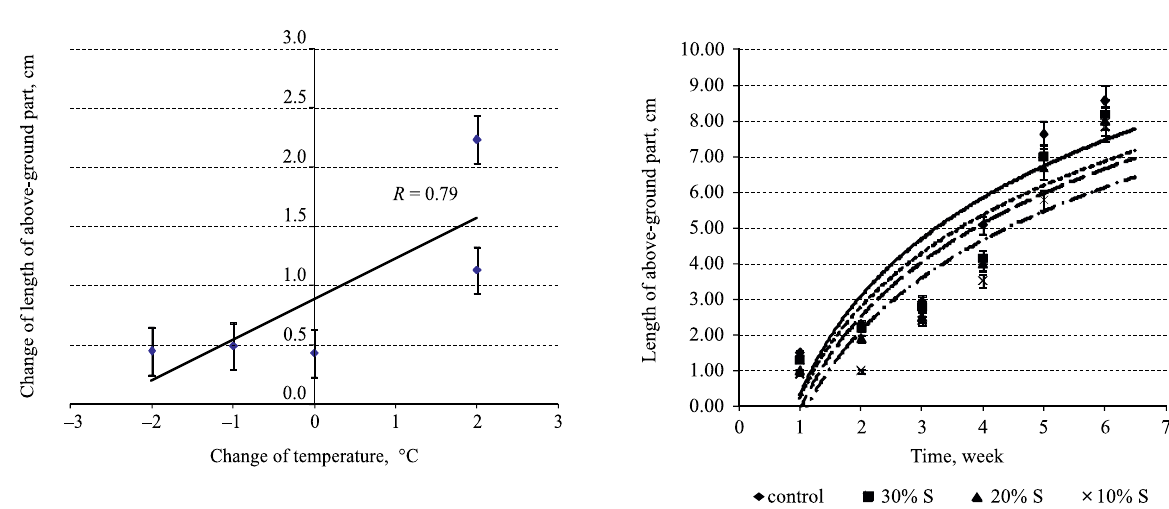
Fig. 12. Change of length of above-ground part of white clover dependence on change of temperature